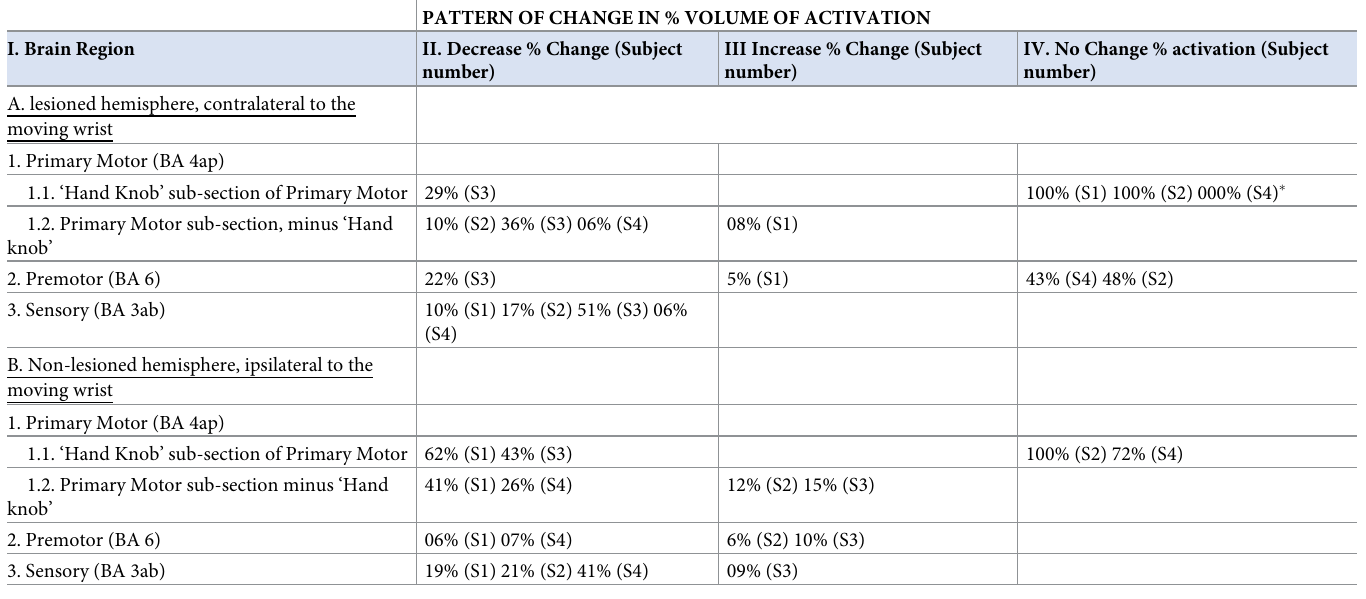
Table 4. Performance during rt-fMRI neural feedback training patterns of change in % volume of activation for specific ROIs across the first and last rt-fMRI neu- ral training sessions. PATTERN OF CHANGE IN % VOLUME OF